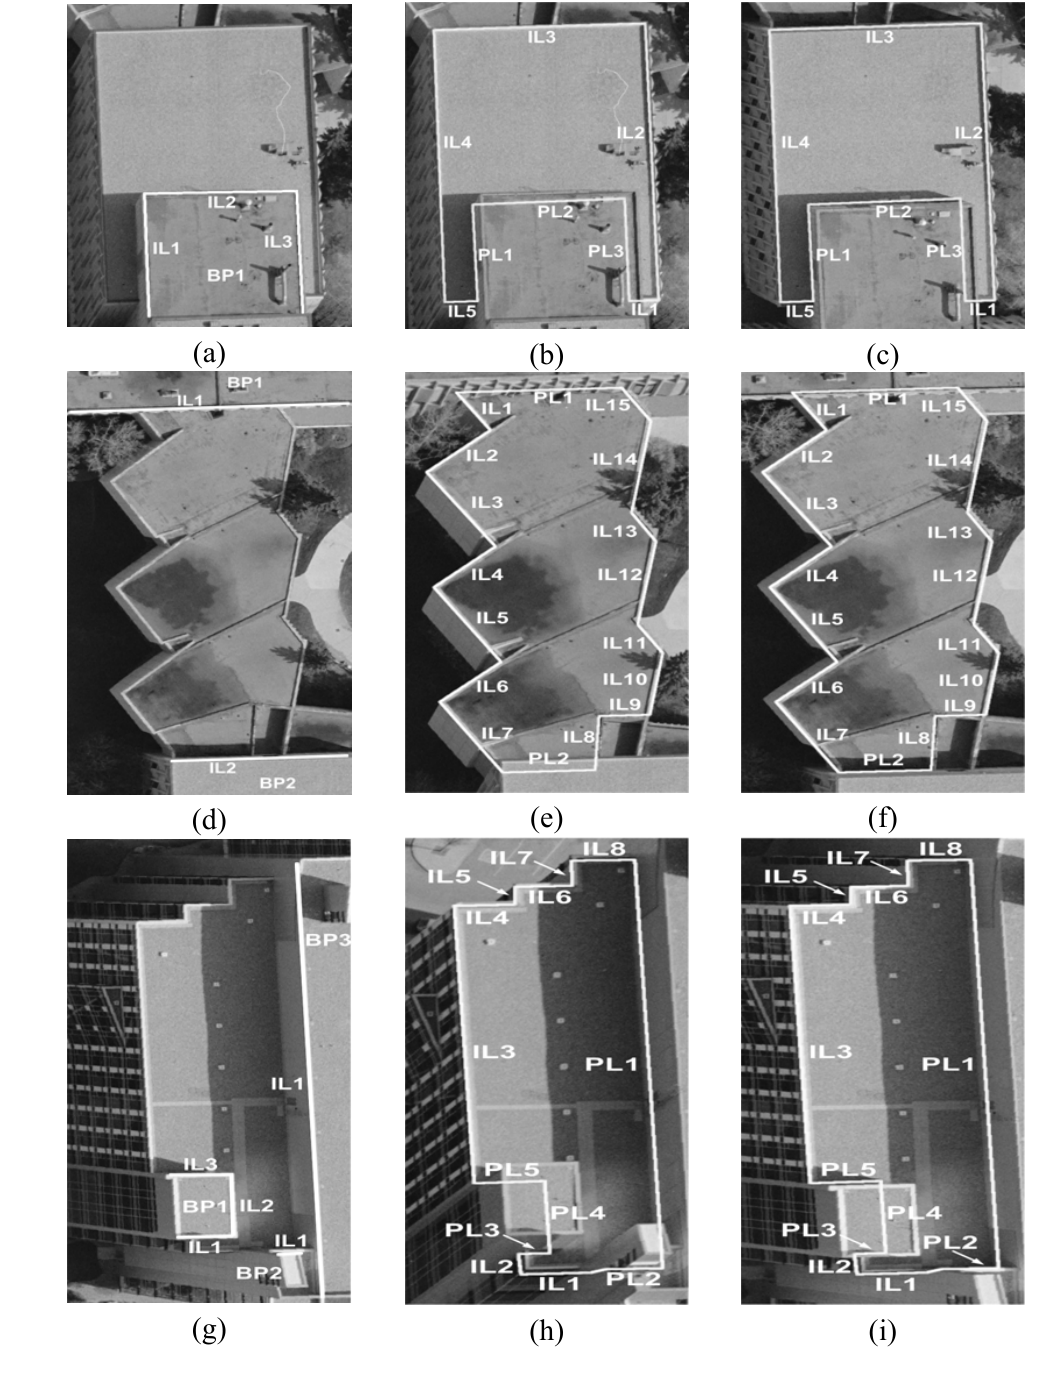
Figure 14. Building primitives with different complexity levels: (a, d, and g) derived line segments for the higher and neighbouring building primitives and refined boundaries projected onto the (b, e, and h) left and (c, f, and i) right warped